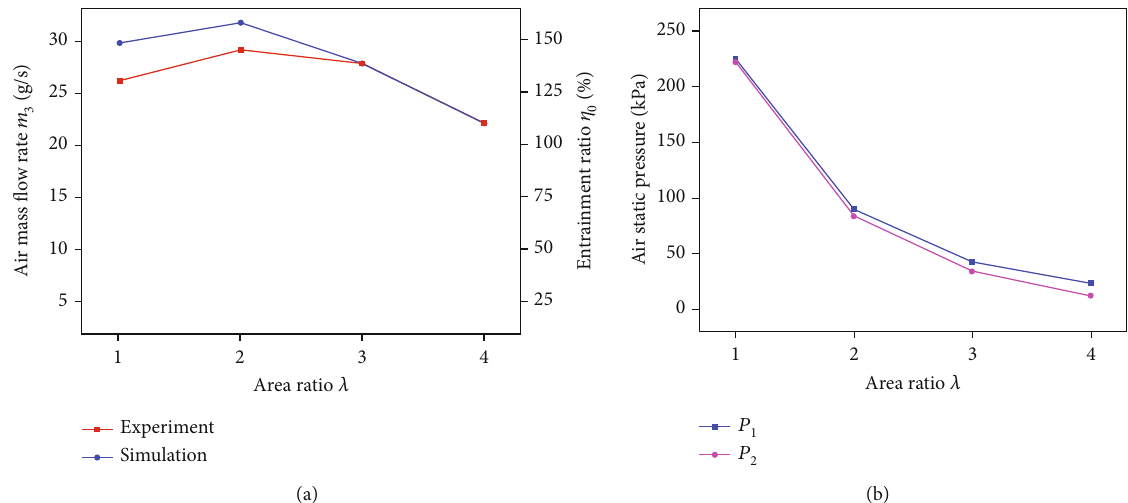
Figure 13: Relationship between area ratio and entrainment performance of drill bit without fl ushing nozzles: (a) entrainment performance; (b) static pressure.